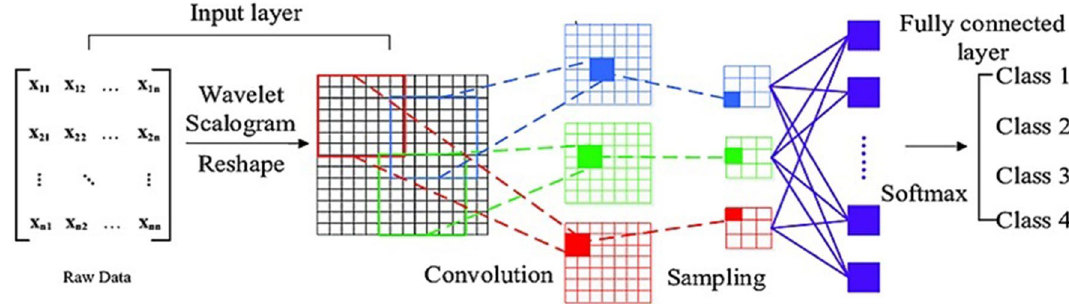
Figure 1. Standard Convolutional Neural Network Architecture usually consists of an input layer, convolution layer, Max pooling and the final fully-connected neural network layer which gives the output based on the activation function 9